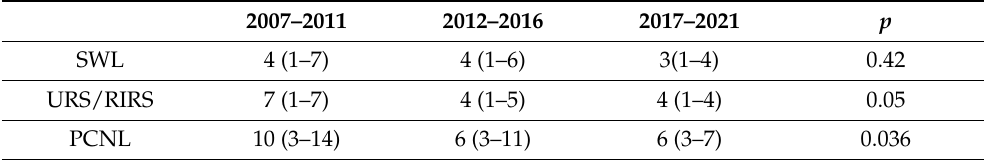
Table 2. Postoperative medical leave (days, median [IQR]).